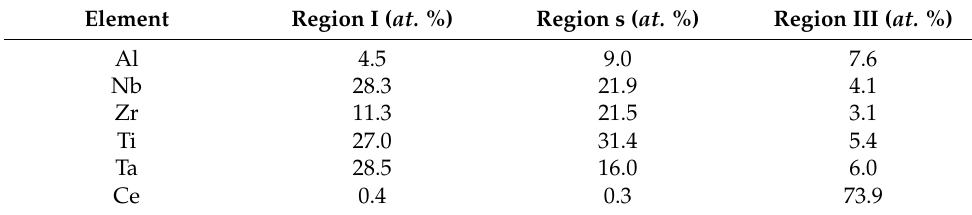
Table 1. Element distribution in different regions in SEM images.